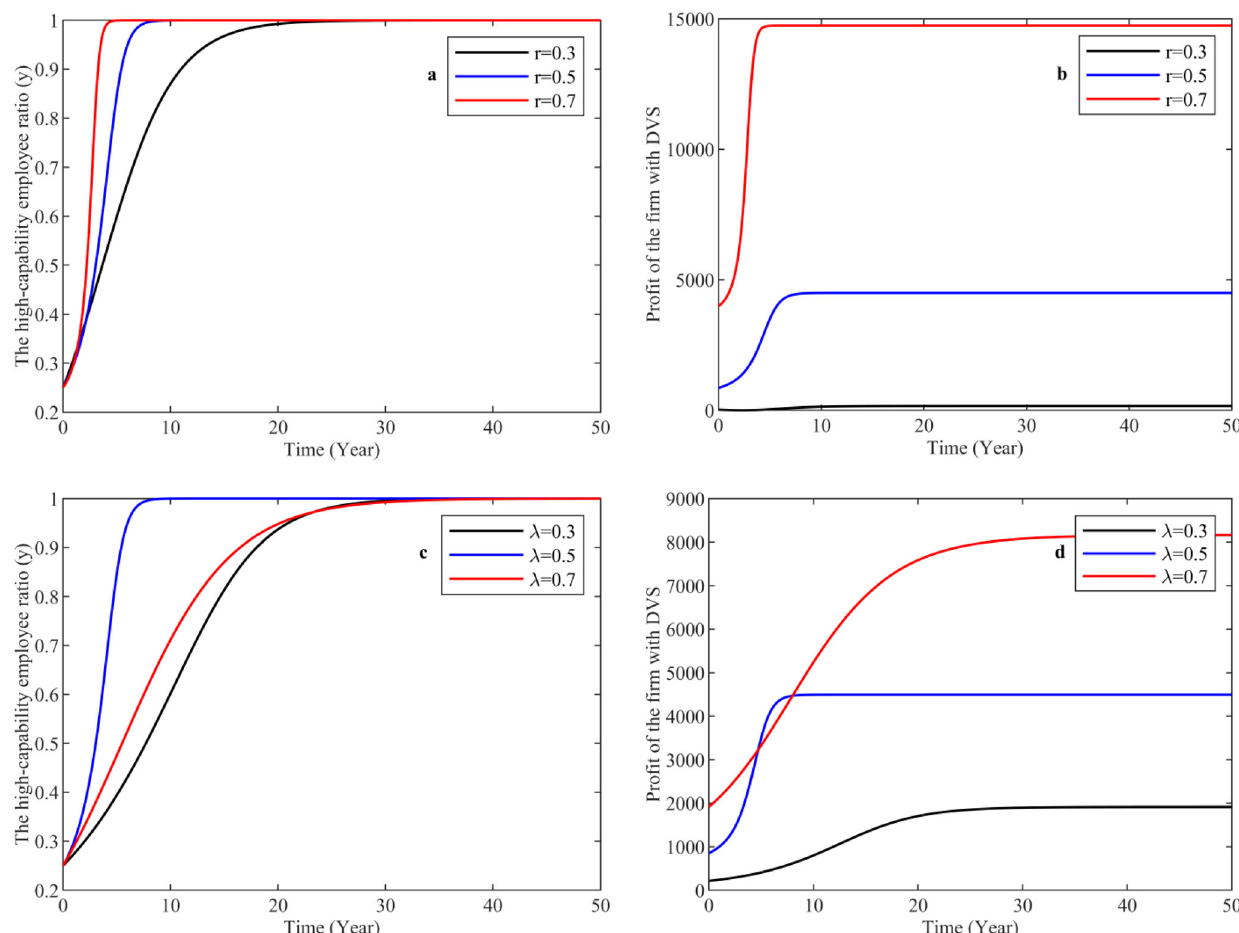
Fig. 9 The effects of incentive capacity coef fi cient ( r ) and transformation capacity coef fi cient ( λ ) on the proportion of high-capability employees and the pro fi t of the fi rm, respectively. a Evolution of high-capability employees with different r . b Evolution of pro fi t with different r . c Evolution of high- capability employees with different λ . d Evolution of pro fi t with different λ